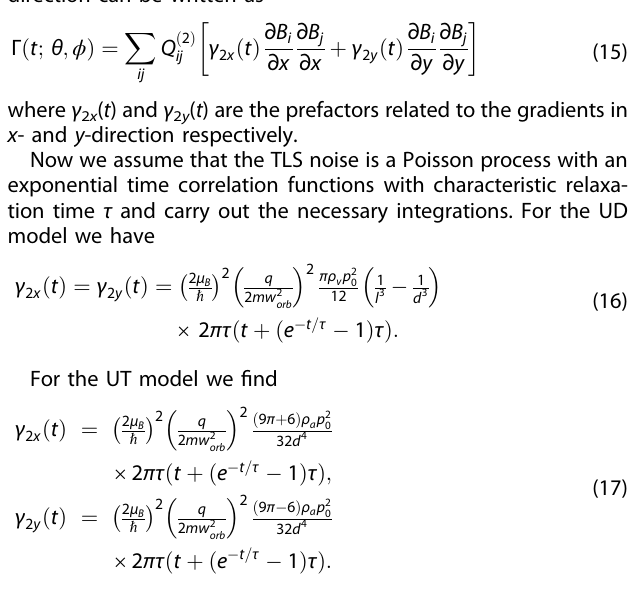
The temporal part of γ 2 x and γ 2 y results from the integration of the product of a Lorentzian g ( ω ) = 2 τ /(1 + ( ωτ ) 2 ), and sinc 2 ( ω t /2). Those equations are obtained by converting electric fi eld noise correlations (Eq. (12) or Eq. (13)) into effective magnetic fi eld correlation using Eq. (7) (See details in Supplementary Notes). It is important to note fi rst that the details of the noise spectrum and thus the choice of an exponential correlation are not crucial for the anisotropy patterns, since they depend only on ratios of noise strengths. On the negative side, if some parameter of the noise such as τ itself depends on position in the sample, then the extraction of useful information from the analysis of the data would become far more complicated. ρ